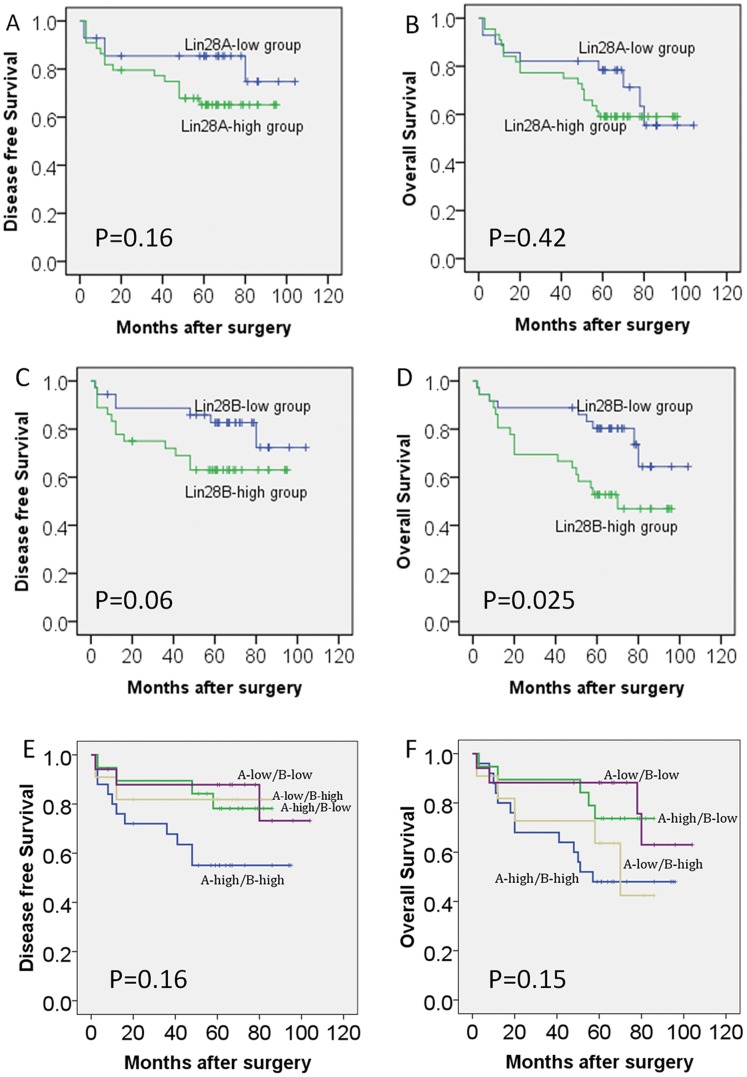
Kaplan–Meier survival curve for disease-free survival (A, C, E) and overall survival (B, C, F) for Lin28A (A, B), Lin28B (C, D) and co-expression of Lin28A and Lin28B (E, F) in OSCCs.P value was determined by a two-sided log-rank test.